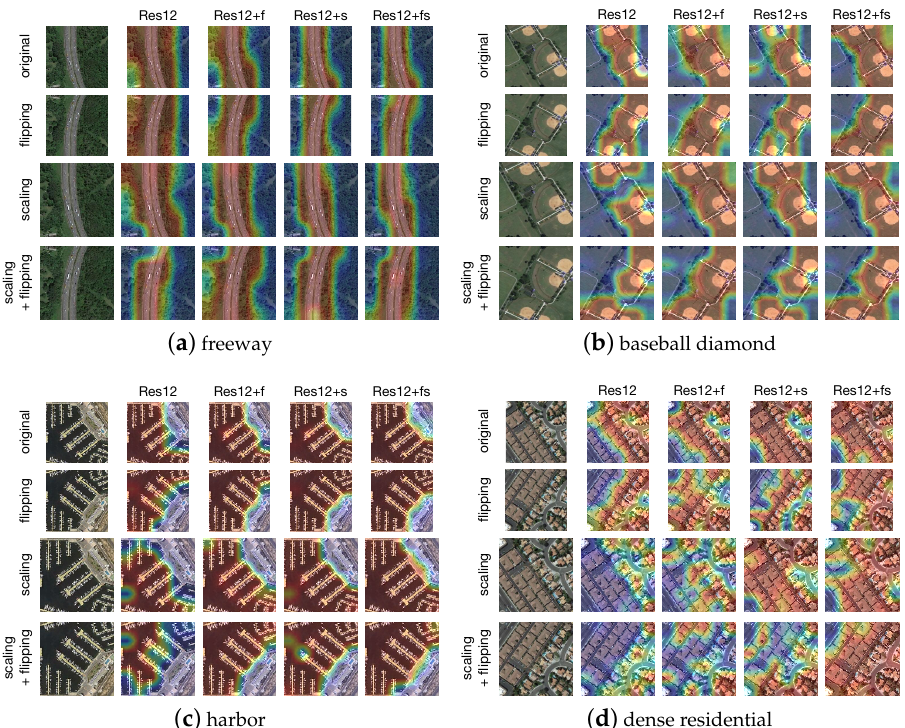
Figure 14. Class activation maps (Cams) visualization according to the labels: ( a ) freeway; ( b ) baseball diamond; ( c ) harbor; and ( d ) dense residential using different